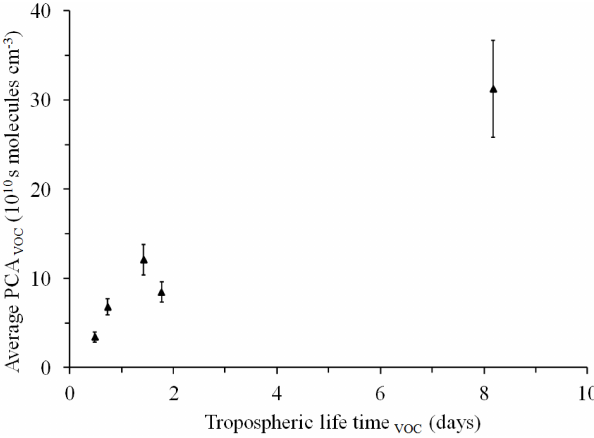
Figure 6. Dependence between average R [OH]d t (photochemical age, PCA) and photochemical lifetime for light aromatic VOC. The average tropospheric lifetime was calculated using the rate con- stants given in Table 10 and an average tropospheric concentration of 1.16 × 10 6 OH-radicalscm − 3 (Spivakovsky et al., 2000). Vertical error bars are the standard error of the mean.